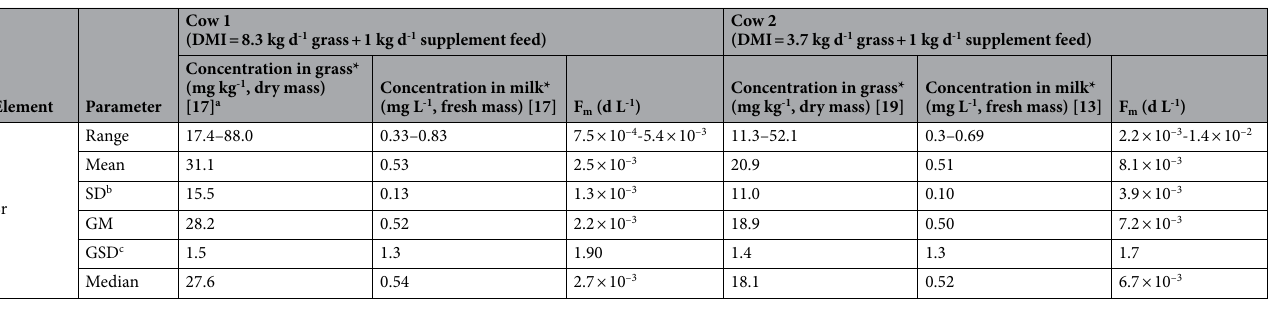
Table 4. Stable Sr concentration in grass grown in the experimental field and milk and F m values for the cows raised for the study. a Values within the square bracket represents samples analyzed. b SD represents standard deviation. c GSD represents the geometric standard deviation (unitless). d Sr concentration in the supplement feed was below the detection